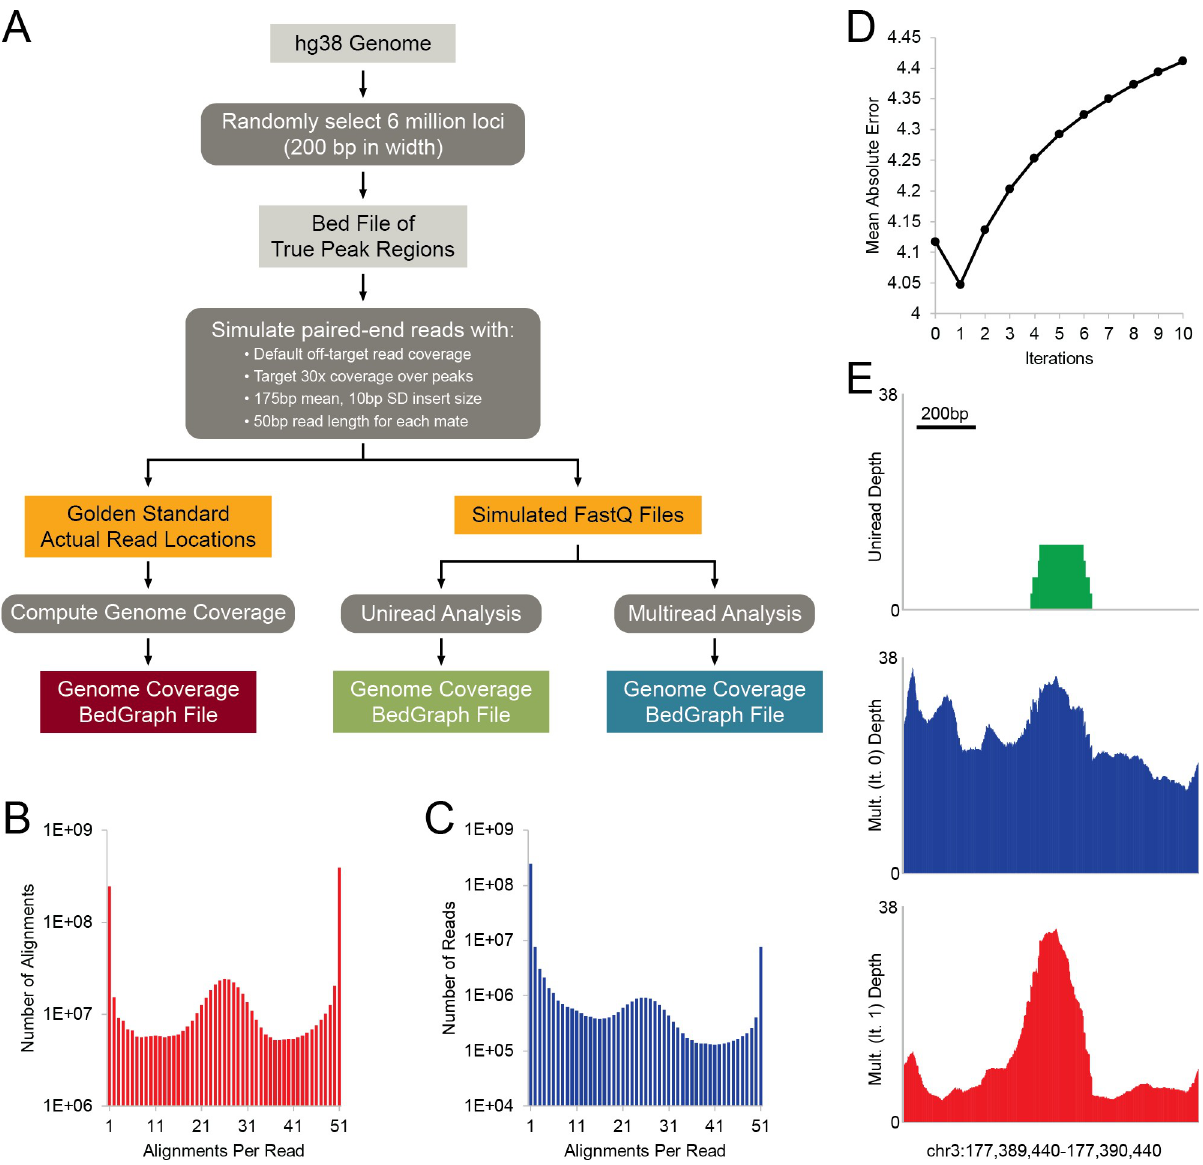
Fig 2. Characteristics of validation dataset. (A) Schematic outlining the workflow to validate and optimize SmartMap. A set of six million randomly selected 200bp loci were used to simulate paired end reads. The true read depth distribution was then compared to both uniread and SmartMap analyses, with each analysis conducted in both “scored” and “unscored” modes, per Methods. (B, C) Number of (B) alignments or (C) reads vs. number of alignments per read for the validation datasets. (D) Mean absolute error of read depth at true origin loci in SmartMap scored mode vs. number of reweighting iterations (E) Genome browser view showing the read depth in the (top) uniread, (center) SmartMap (0 iterations), and (bottom) SmartMap (1 iteration) datasets of an example locus.